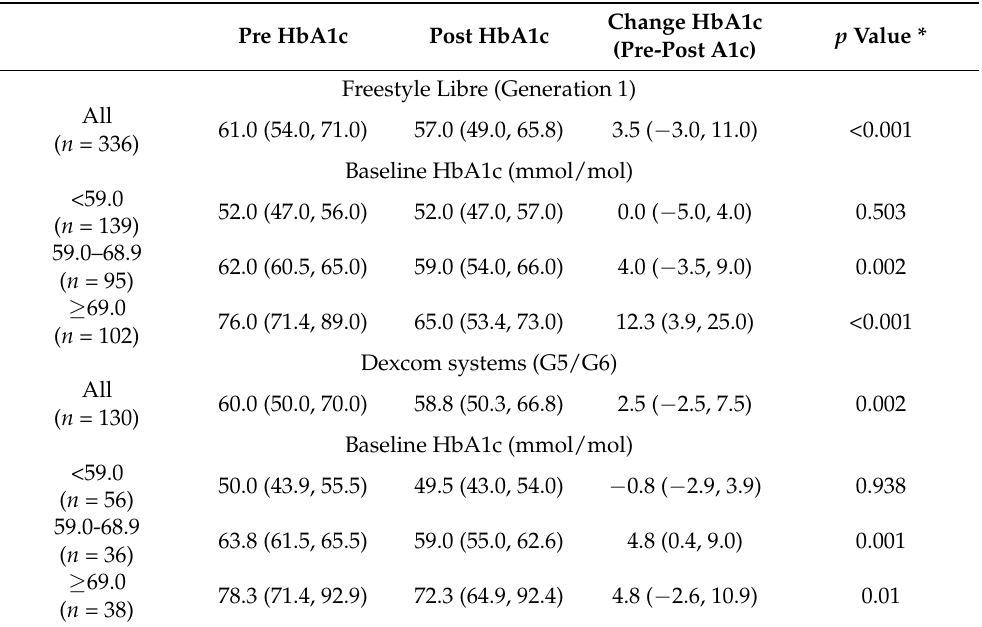
Table 2. HbA1c changes within one year of starting Freestyle Libre (Generation 1) and Dexcom (G5 and G6) systems in people with type 1